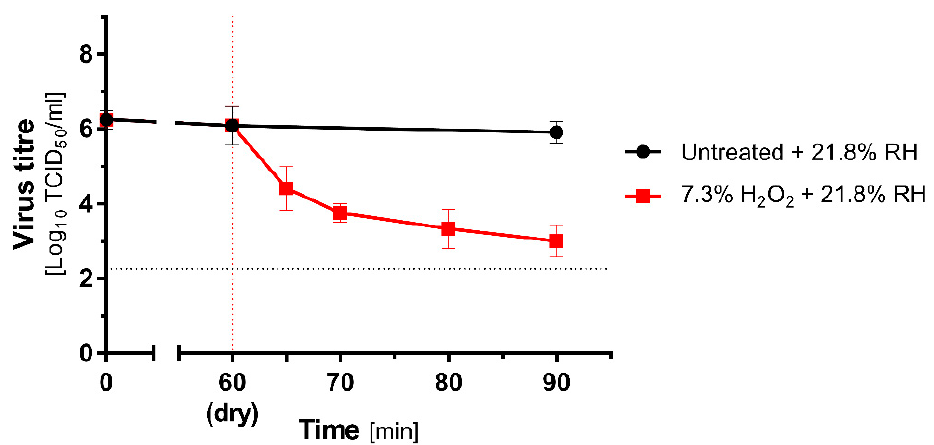
Figure 5. Effectiveness of H 2 O 2 treatment on MHV dried on stainless steel carriers. Comparison of mean ( ± SD, n = 3) titres of MHV recovered from contaminated carriers subjected to hydrogen peroxide treatment (7.3%; red lines) and untreated (black lines) at 21.8% RH (low RH). The vertical dotted line represents the end of drying and beginning of H 2 O 2 treatment, and the horizontal dotted line represents 4 logs virucidal efficiency threshold with respect to the initial titre.